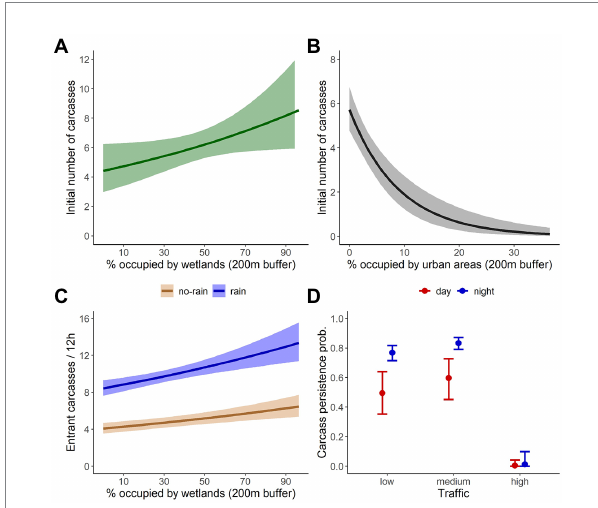
FIGURE 3 Predicted relations from the dynamic N-mixture model applied for dependent double-observer counts of amphibian carcasses. Relationship of the initial number of carcasses with (A) wetlands coverage, and (B) coverage of urban areas; (C) the number of entrant carcasses with wetlands coverage for rainy and not-rainy intervals; and (D) the carcass persistence probability with traffic volume and time of the day. Shaded areas and error bars represent the 95% credibility intervals.